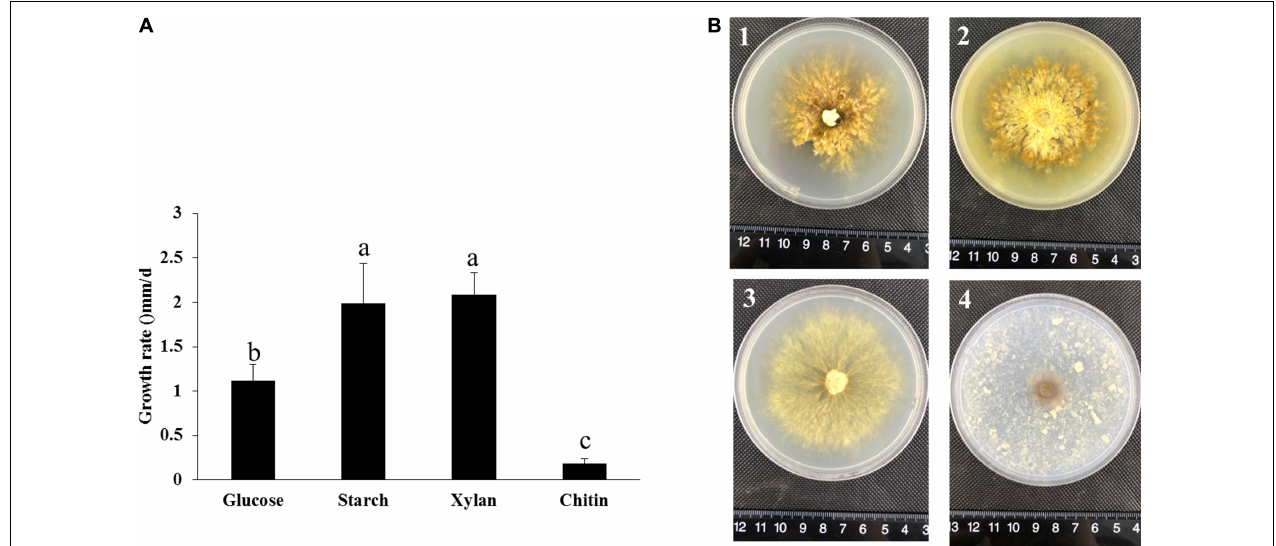
FIGURE 7 | The growth rate and morphology of P. portentosus cultured on different carbon sources. (A) Growth rate; (B) morphology of P. portentosus on different carbon sources after 30 days of cultivation, (B1) glucose, (B2) starch, (B3) xylan, (B4) chitin. Different lowercase letters above bars indicate a significant difference according to the Duncan’s multiple range test ( p <